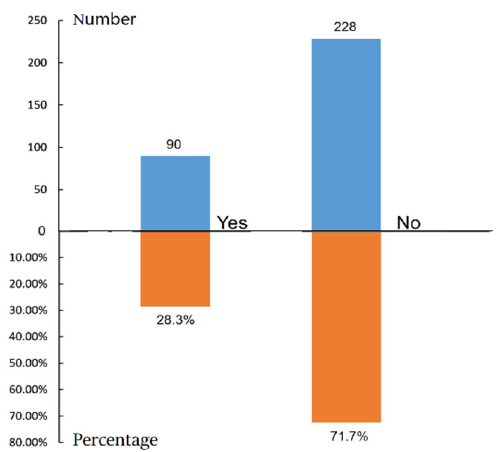
Figure 7. Farmers’ waste classification behavior.